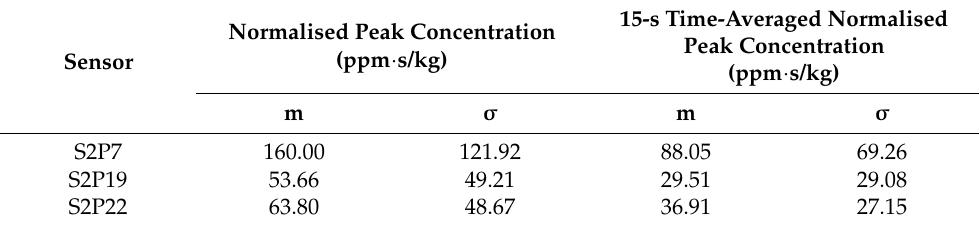
Table 2. The puff releases dosage and peak concentration (m: ensemble average, σ : standard deviation) normalised by the released puff mass and the puff release rate, respectively.